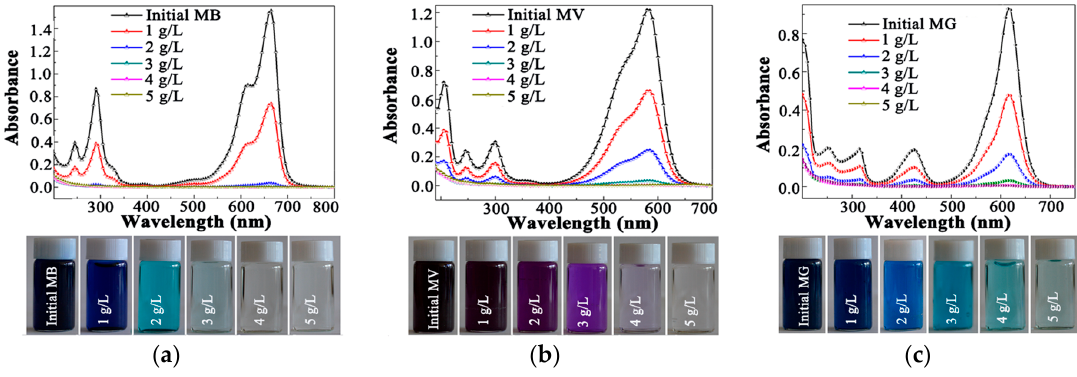
Figure 7. UV–VIS spectra of MB ( a ), MV ( b ), and MG solutions ( c ) after adsorption by C/APT-Re1; digital photographs of the MB, MV, and MG solutions.